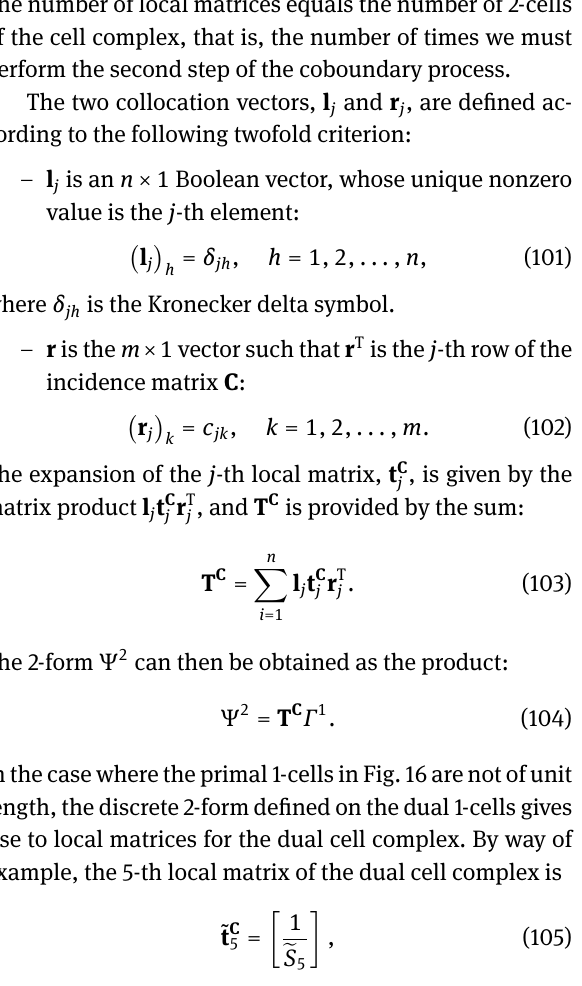
(a scalar), whose unique j